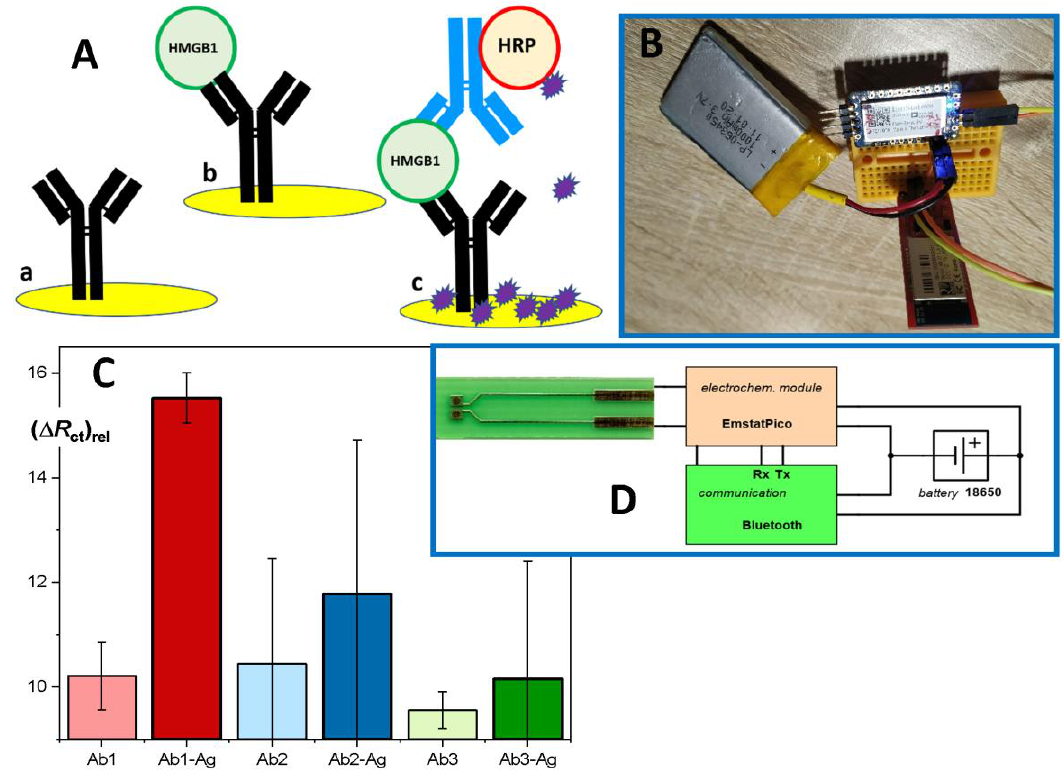
Figure 3. Concept of the HMGB1 immunosensor. ( A ) A gold electrode is modified with a capture antibody (a), and after incubation with the sample, the formed immunocomplex can be detected, not as a color change (ELISA) but as a change in impedance (b). An amplified response can be obtained using a sandwich format with secondary Ab-HRP conjugate, where the product of the enzyme label reaction precipitates on the electrode surface. ( B , D ) The electrochemical module EmstatPico (PalmSens) was linked to a Bluetooth module RN-42 (Sparkfun, or other similar) and communicated with a control smartphone (tablet or PC). The disposable sensor was based on printed circuit board technology ( D , left). ( C ) Impedance changes depending on the choice of the capture antibody: light color—blank; dark color—positive samples of recombinant HMGB1